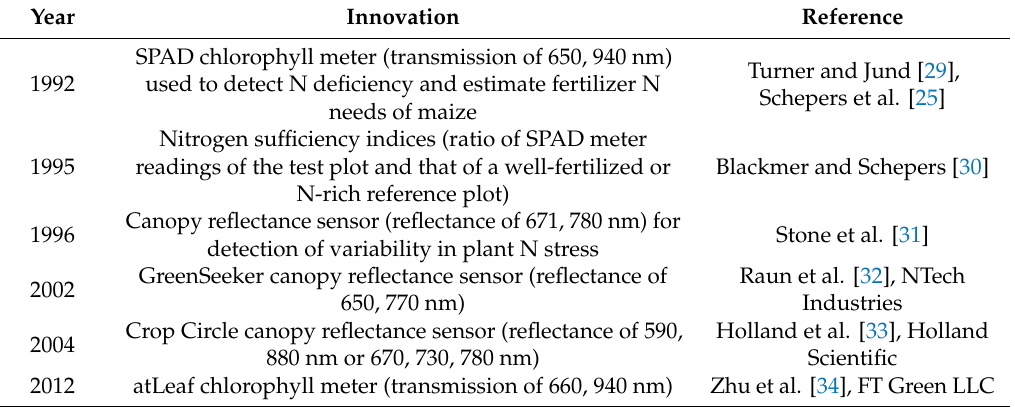
Table 1. Innovations in proximal leaf sensing as used for guiding fertilizer N management in precision